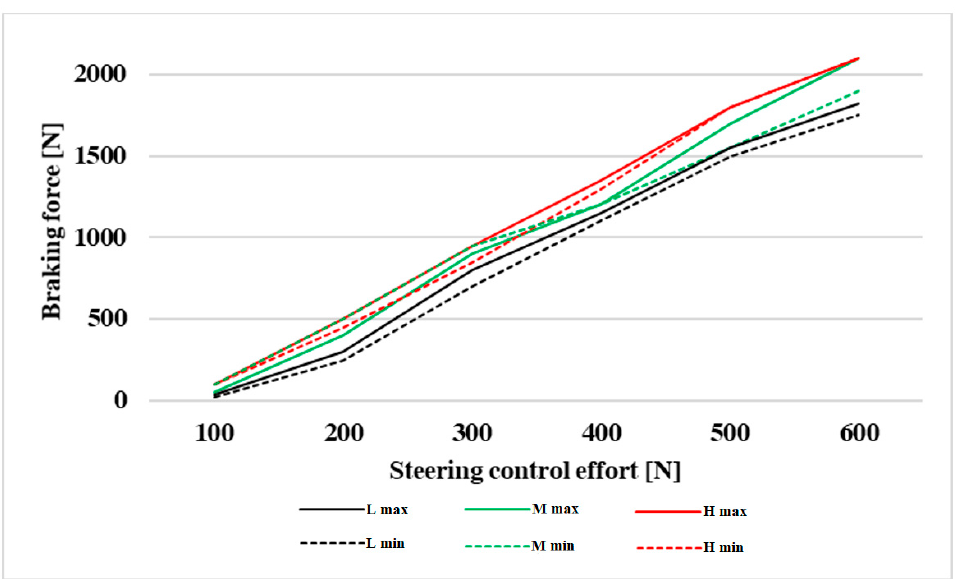
Figure 12. Braking force depending on effort to control the steering.